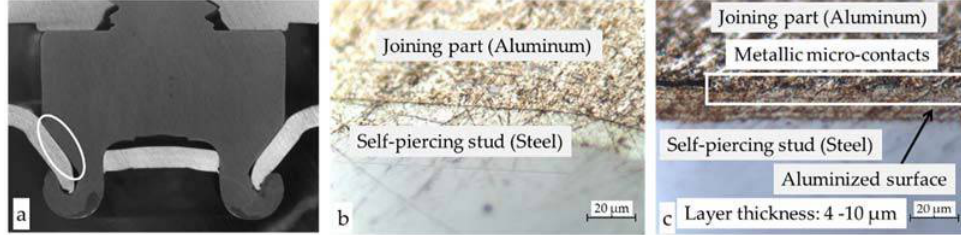
Figure 10. Metallographic cross-section of the fastening section ( a ), of surface layers at self-piercing studs with zinc coating ( b ) and Al-Cr coating at the self-piercing stud ( c ) [20]. In Figure 10b, a clear boundary can be seen. There, the electrical contact is based on the present force-closure component. In the picture in Figure 10c, a metallic a-spot can be seen. During the joining process of the self-piercing stud, a contact surface not contaminated with foreign layers is created when the bus bar plane is cut through. The additional relative movement between the contact partners leads to the breakup of impurity layers, in particular oxide layers on the surface of the bus bar, and a-spots arise [20]. In addition to the form- and force-closure components, there is also a material-closure component, which ensures the significantly reduced electrical resistance and the stable electrical long-term behavior of the self-piercing stud made of steel with the aluminized surface in aluminum bus bars.